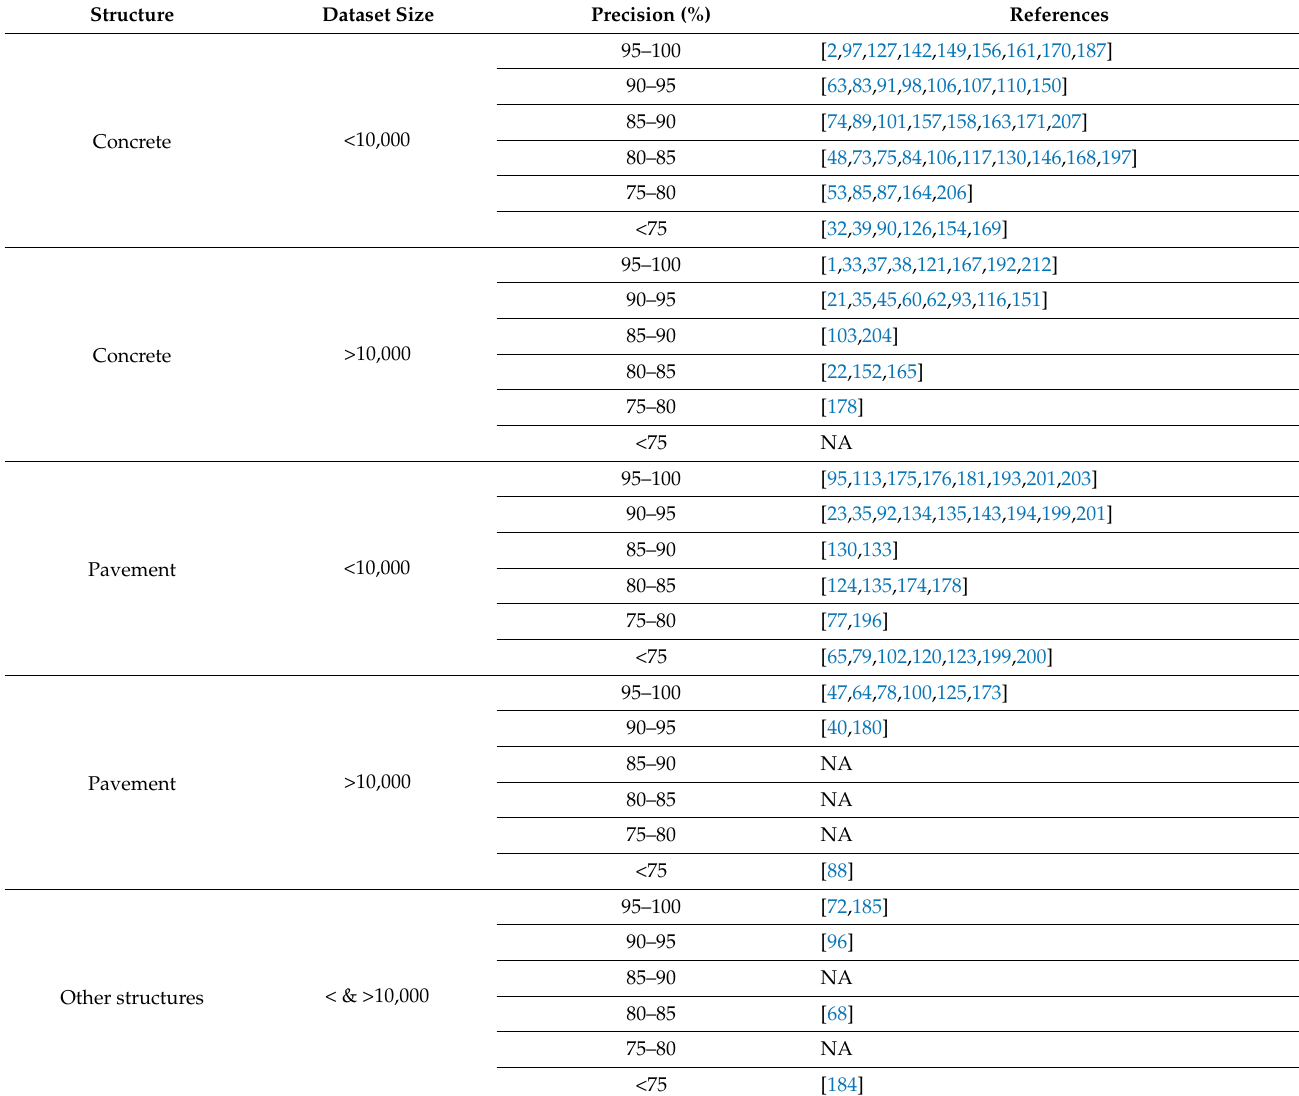
Table 13. Distribution of the published articles on crack detection (precision